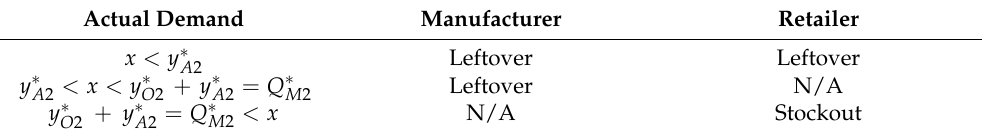
) . , y ∗ , Q ∗ M 2 A 2 O 2